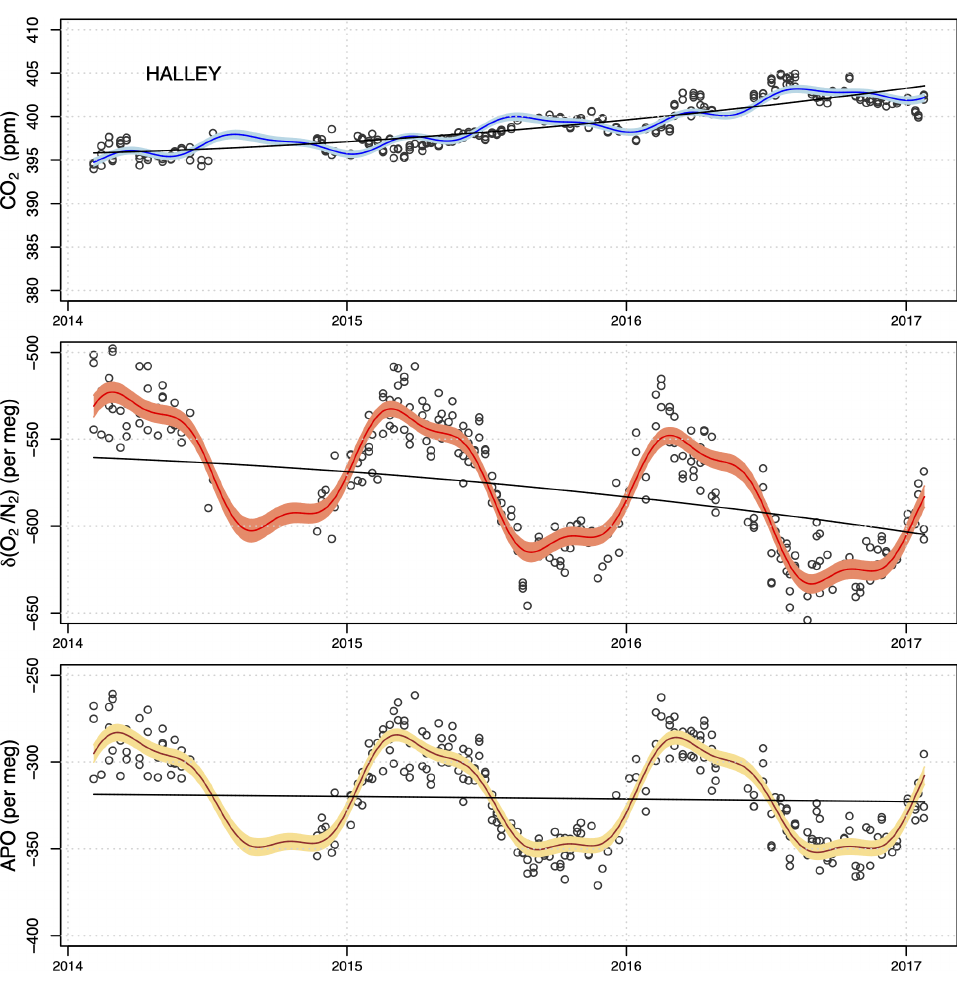
Figure 9. As for Figs. 7 and 8, but for Halley station and from 2014 to 2017.